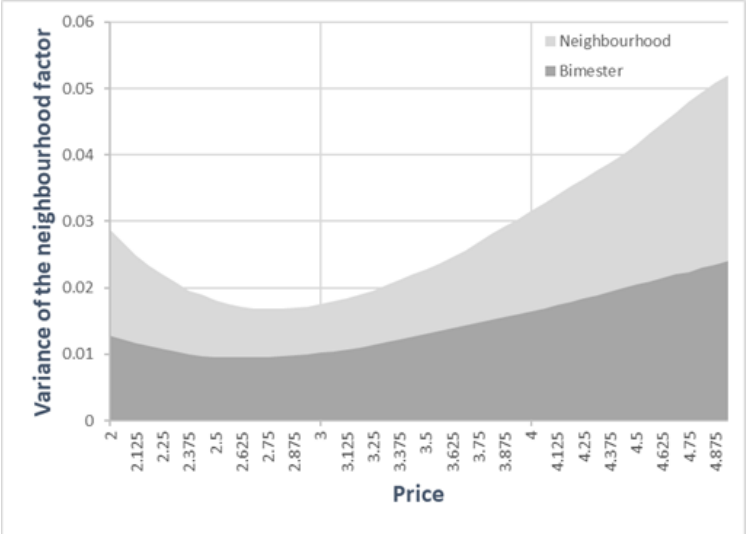
Figure 7. Variance partition coefficient